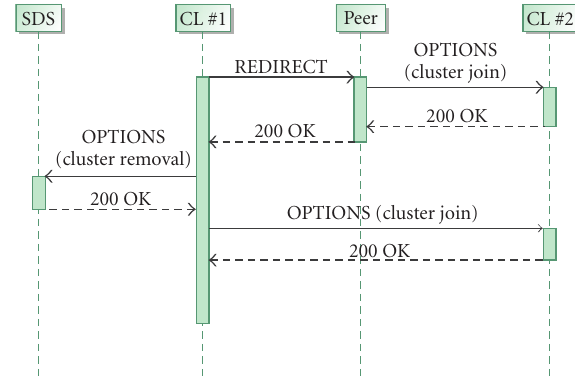
Figure 5: Successful cluster merging